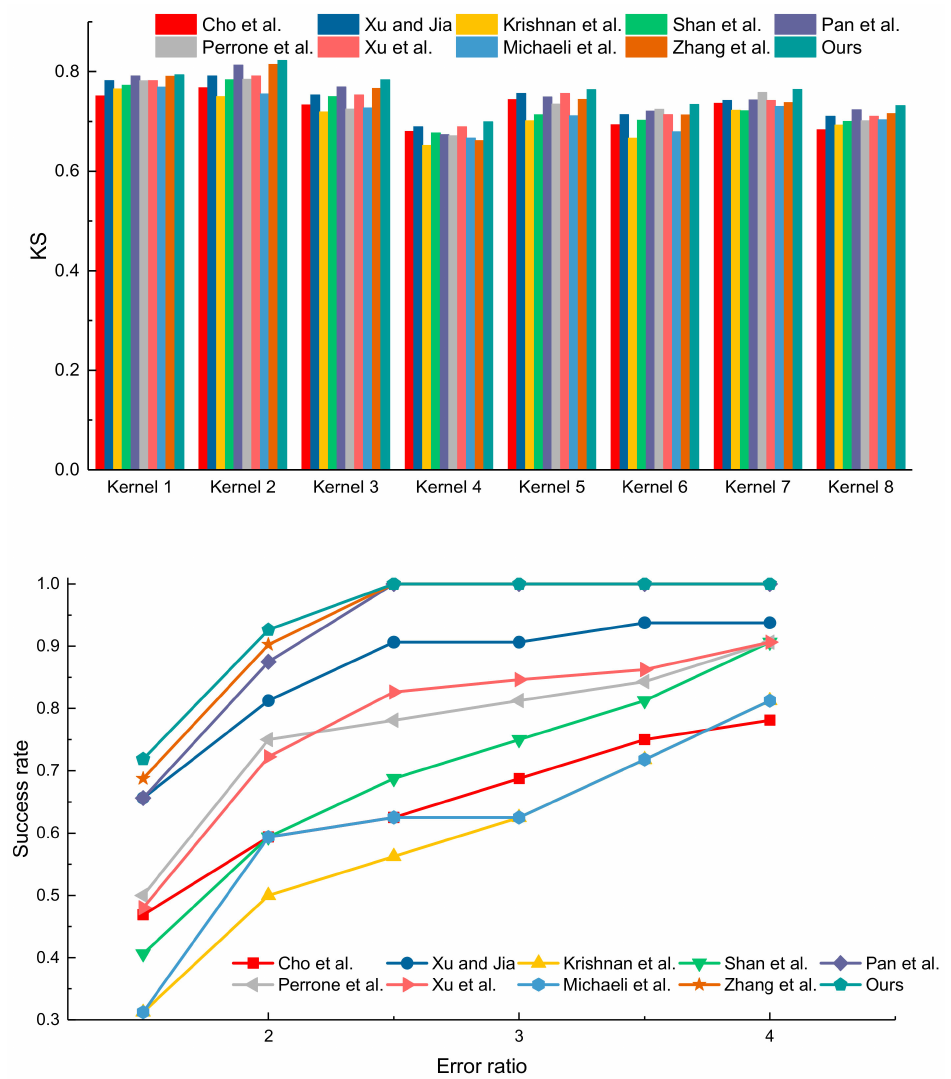
Figure 8. Quantitative results on the dataset of Levin et